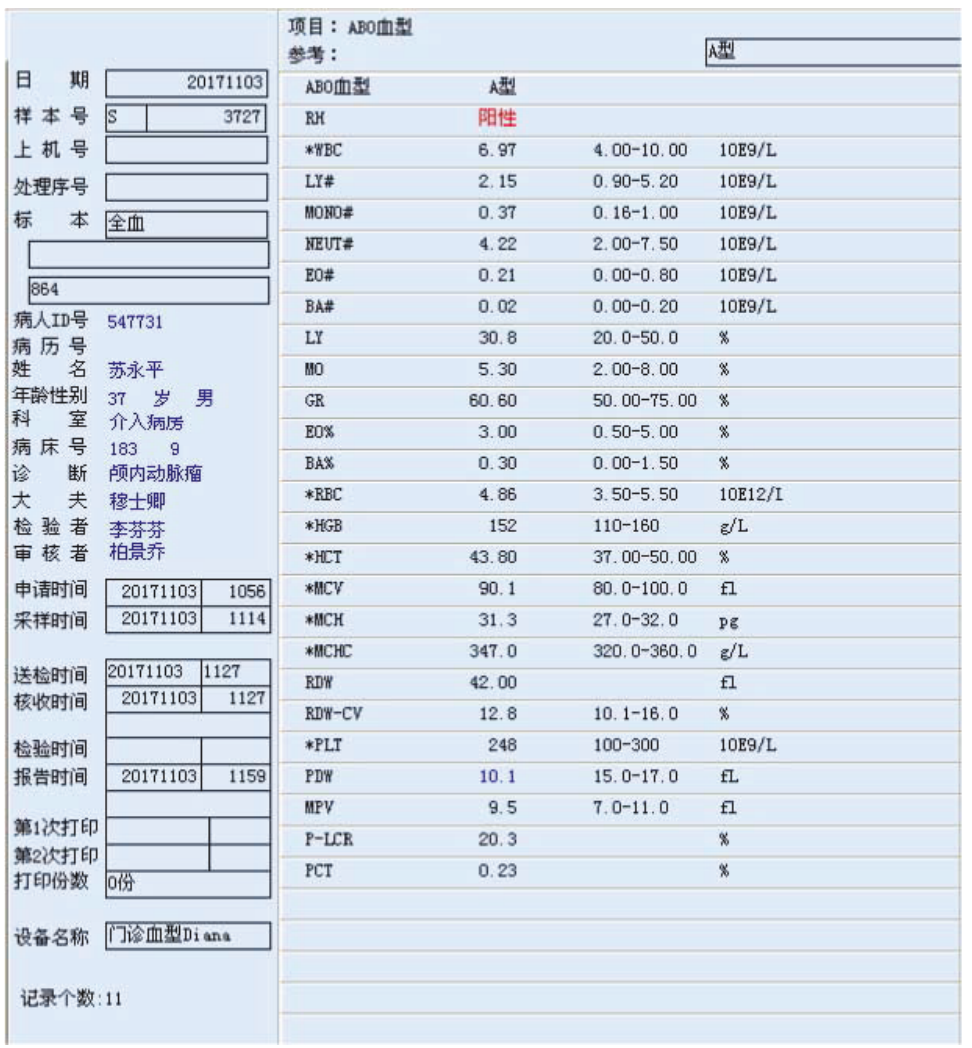
Figure 6: Preoperative blood routine